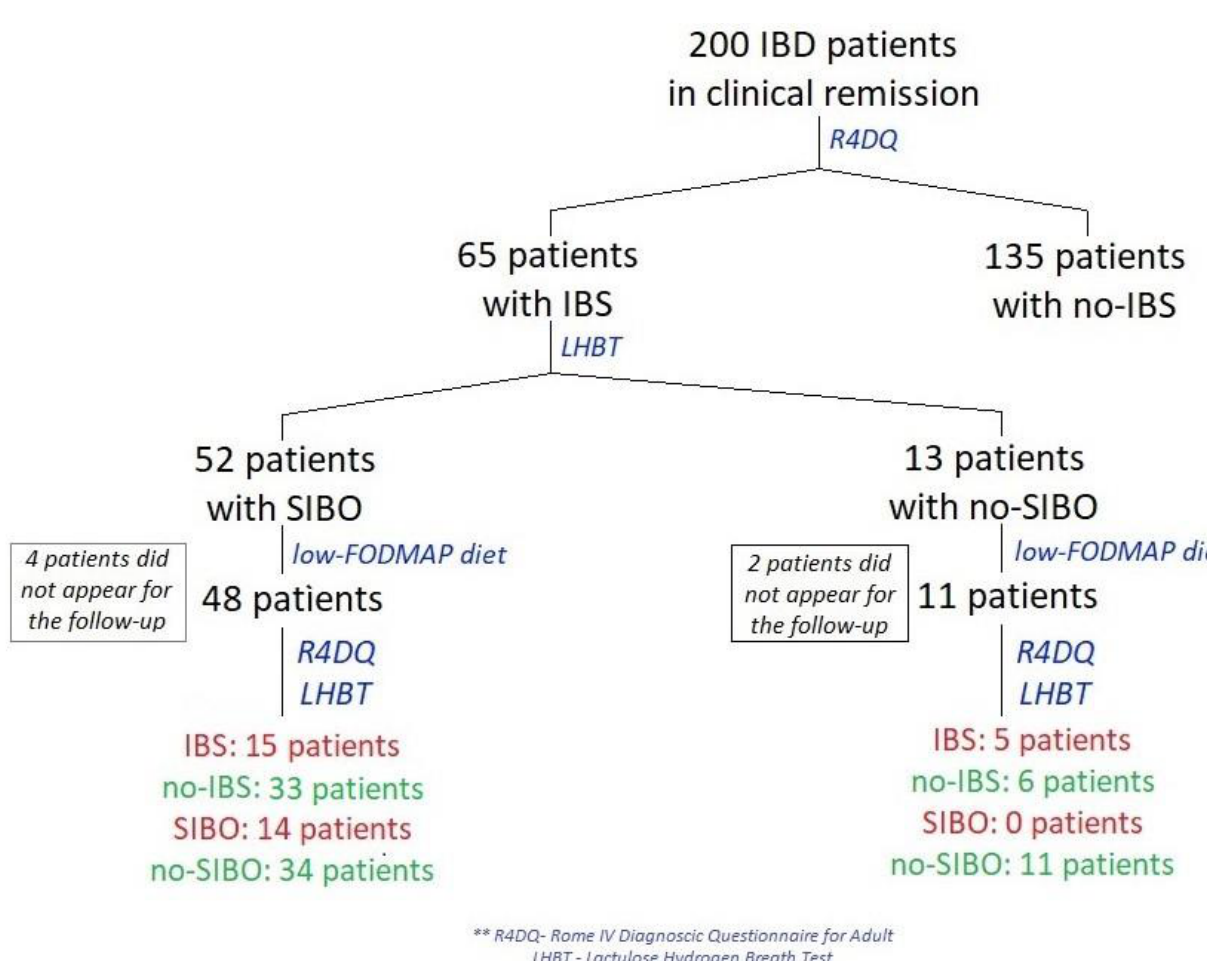
Figure 1. Flow diagram of patients in remission of IBD treated with a low-FODMAP diet. The patients who met the IBS diagnostic criteria were seen at baseline and at week 6 of the study. During these visits, anthropometric measurements (height, weight and BMI) were taken, CDAI and PMS were calculated, laboratory tests (peripheral blood count, CRP, ESR, creatinine, urea, uric acid, ALT, AST, total bilirubin, ALP, GGTP, albumin, total protein, sodium, potassium, calcium, iron, ferritin, vitamin B12, folic acid, vitamin D3 and calprotectin levels and a fecal culture) and a lactulose hydrogen breath test (LHBT) were performed. After consumption of 10 g (20 mL) lactulose, the rise in breath hydrogen by 20 ppm above the basal within 90 min after ingestion of lactulose was considered as di- agnostic of SIBO. The severity of the symptoms (flatulence, diarrhea, constipation) was determined subjectively by patients at baseline and at week 6 of the study. Low-FODMAP effectiveness was defined as complete resolution of abdominal pain and diminished symp- toms of diarrhea and/or constipation. It was assessed subjectively by the patients and reported to the physician during the follow-up